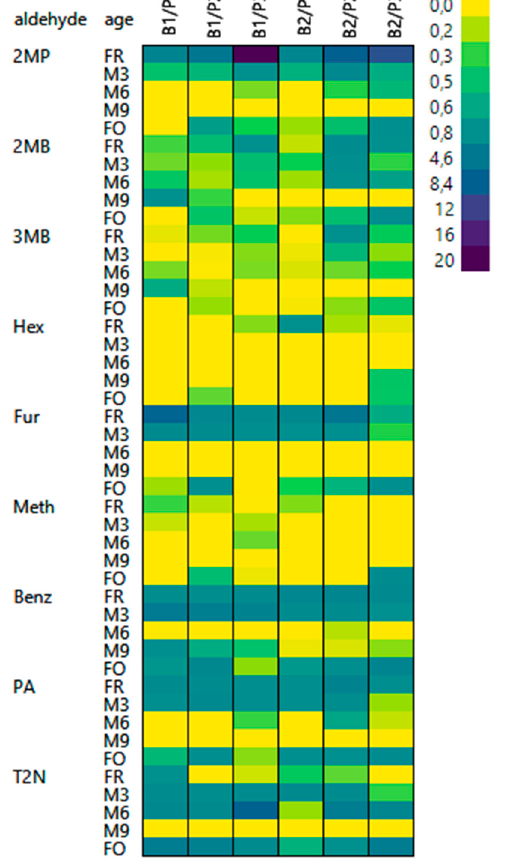
Figure 3. 4VP-releasable aldehydes ( n = 6): the heatmap shows the relative concentration of bound state aldehydes in comparison to the free form (B1: barley variety 1; B2: barley variety 2; P1: low proteolytic malt modification; P2: medium proteolytic malt modification; P3: high proteolytic malt modification).